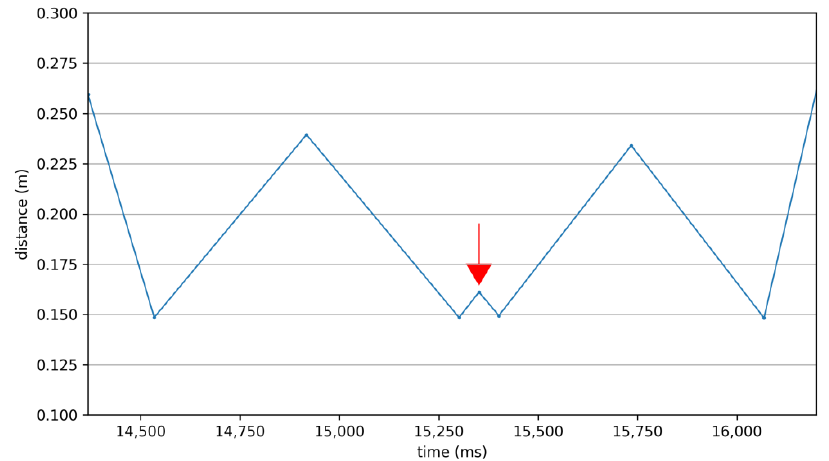
Figure 11. Plot of distance between heels. A freezing of gait episode that occurred during the test is clearly visible and is highlighted by the red arrow.